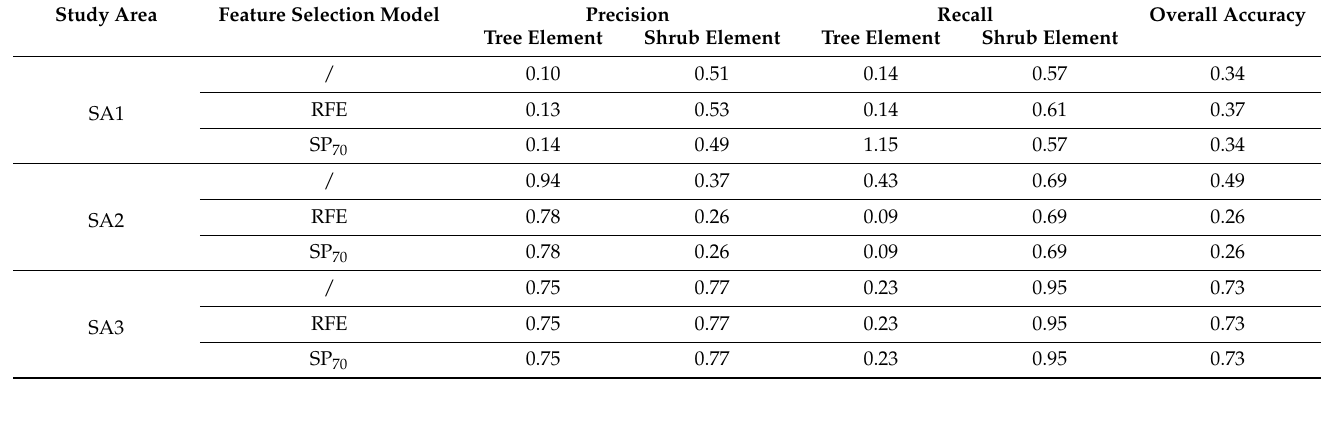
Table 8. Precision, recall, and overall accuracy of the developed workflow.